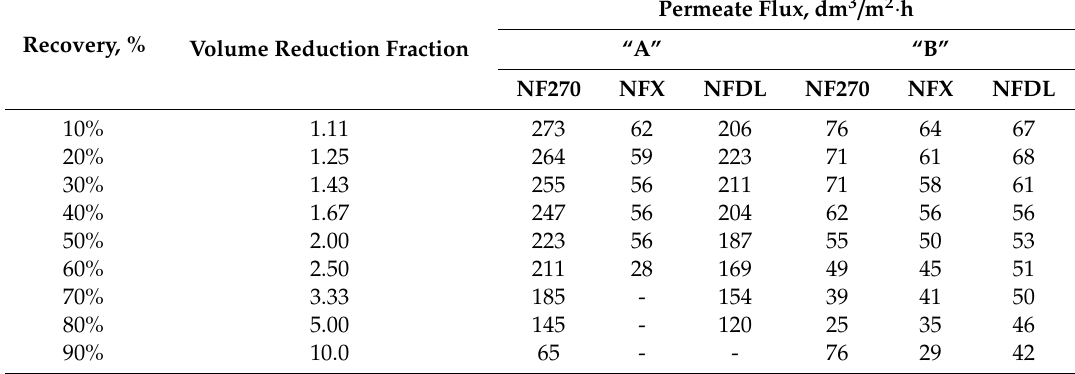
Figure A5. Rejection coe ffi cient, R, of Na + as a function of permeate recovery, Y, for NFX, NF270 and NFDL nanofiltration membranes and mine waters “A” (0.384 g / L as Cl − , 1.02 g / L as SO 42 − , 0.107 g / L as Na + , 0.142 g / L as Mg 2 + , 0.312 g / L as Ca 2 + ) and “B” (33.2 g / L as Cl − , 0.937 g / L as SO 42 − , 19.5 g / L as Na + , 0.990 g / L as Mg 2 + , 0.771 g / L as Ca 2 + ). The permeate flows observed in the study are presented in Table A1. Table A1. Permeate flow observed during the batch-mode studies with three di ff erent membranes (NF270, NFX, NFDL) and mine waters “A” (0.384 g / L as Cl − , 1.02 g / L as SO 42 − , 0.107 g / L as Na + , 0.142 g / L as Mg 2 + , 0.312 g / L as Ca 2 + ) and “B” (33.2 g / L as Cl − , 0.937 g / L as SO 42 − , 19.5 g / L as Na +